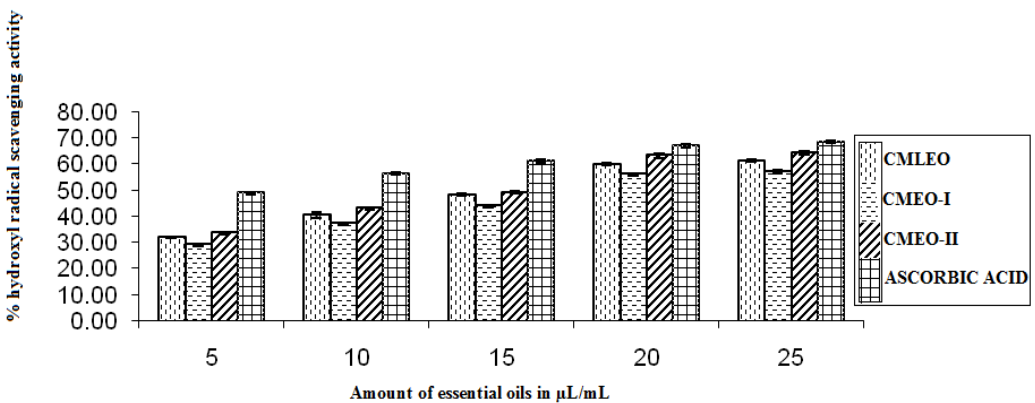
Figure 6. Hydroxyl radical scavenging activity.